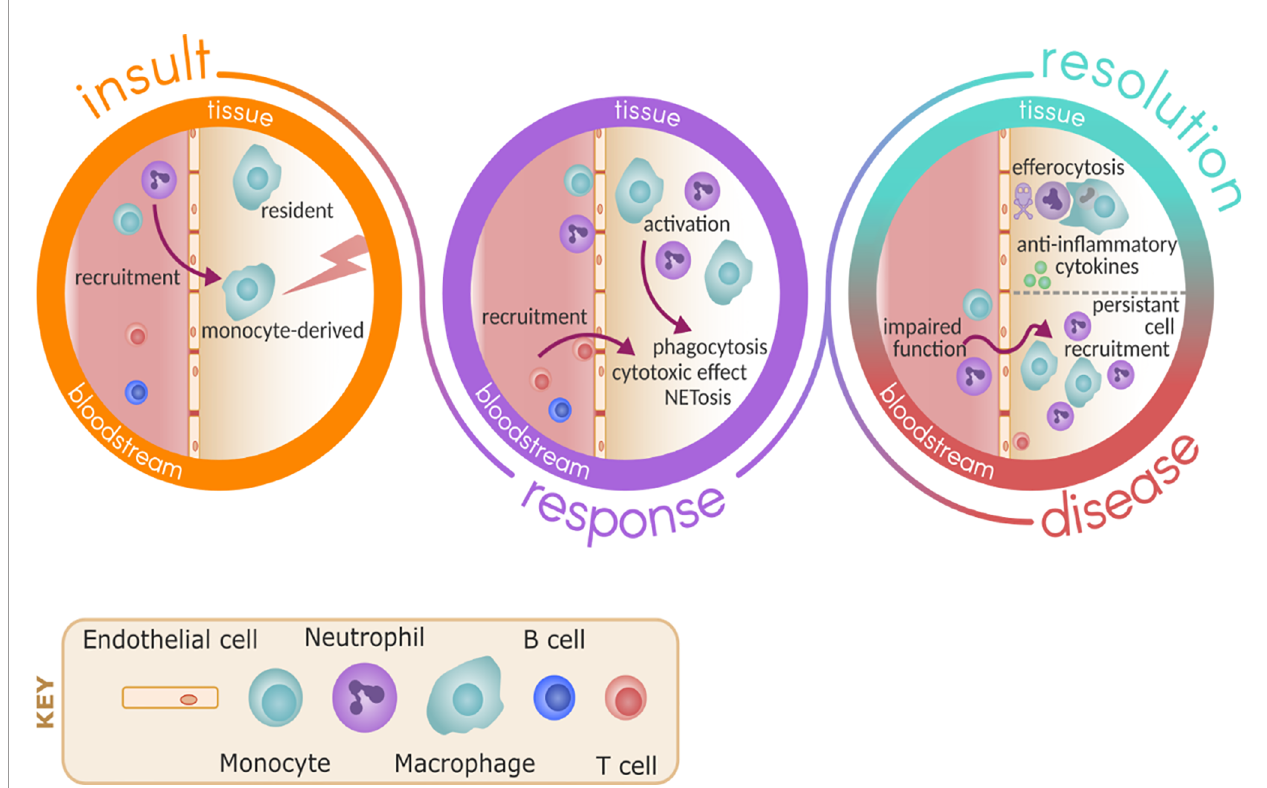
FIGURE 1 | Immune response to in fl ammation and infection. Upon insult, either due to pathogen or sterile injury, resident immune cells such as macrophage are ready to respond and promote the recruitment of monocytes and neutrophils via activation of the endothelium. As part of the response, monocytes differentiate in the tissue to macrophage and these cells become activated to respond to the insult, promoting further recruitment of other immune cells such as T cells and carrying out effector functions including phagocytosis and NETosis. In health, resolution follows by death of neutrophils and clearance by efferocytosis, promoting the release of anti-in fl ammatory cytokines and repair. In disease, the persistent recruitment of immune cells and potential impaired effector functions of these cells perpetuate in fl ammation and